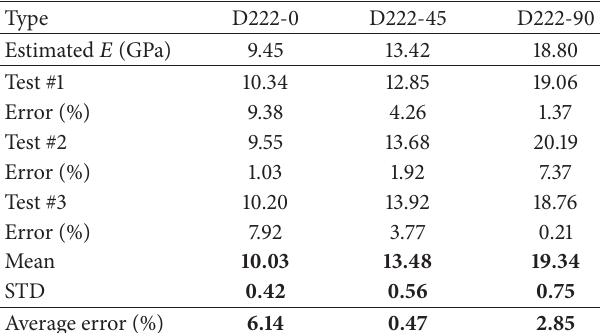
Table 4: The estimated and measured elastic modulus of the 6-layer